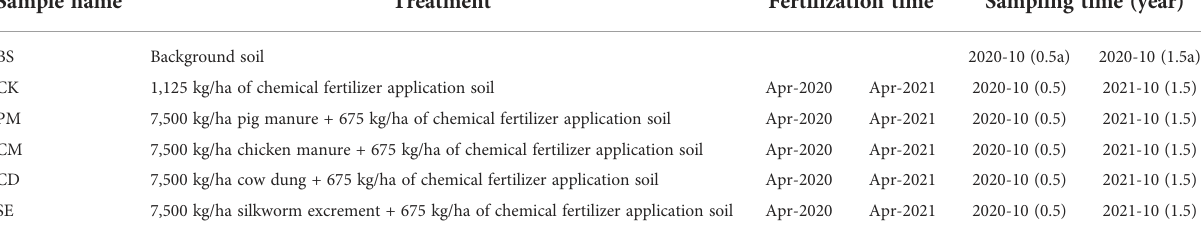
TABLE 1 Sampling setting